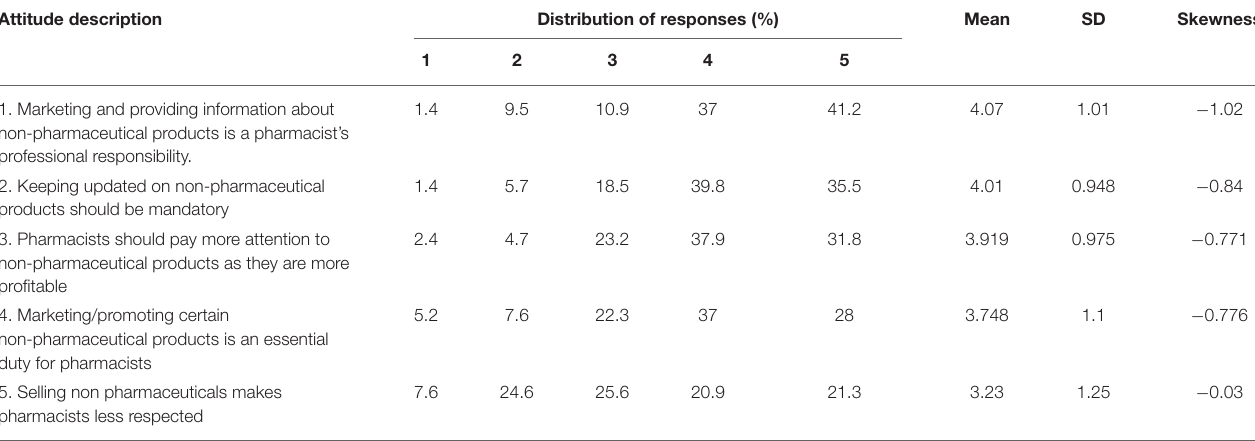
TABLE 3 | Distribution of community pharmacists’ attitude toward non-pharmaceutical products from 1 (strongly disagree) to 5 (strongly agree), n = 211. Attitude description